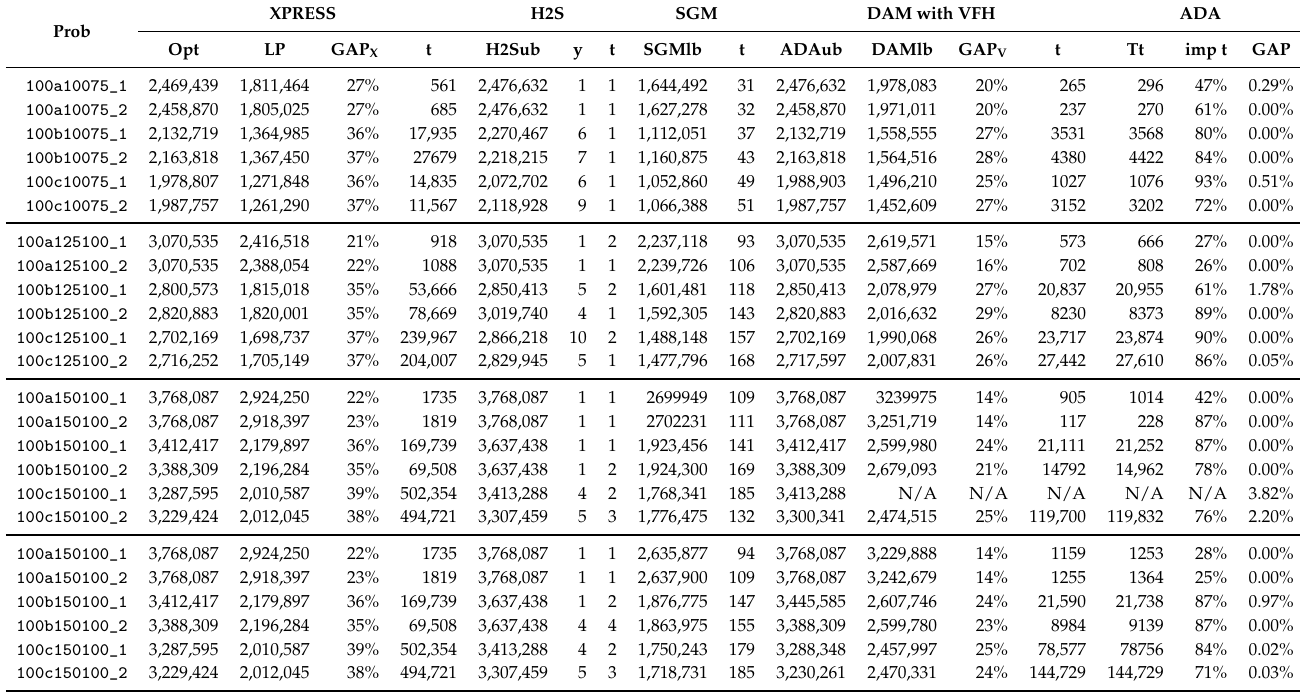
Table 3. ADA algorithm applied to the 2S-SPLPO with two scenarios for m the